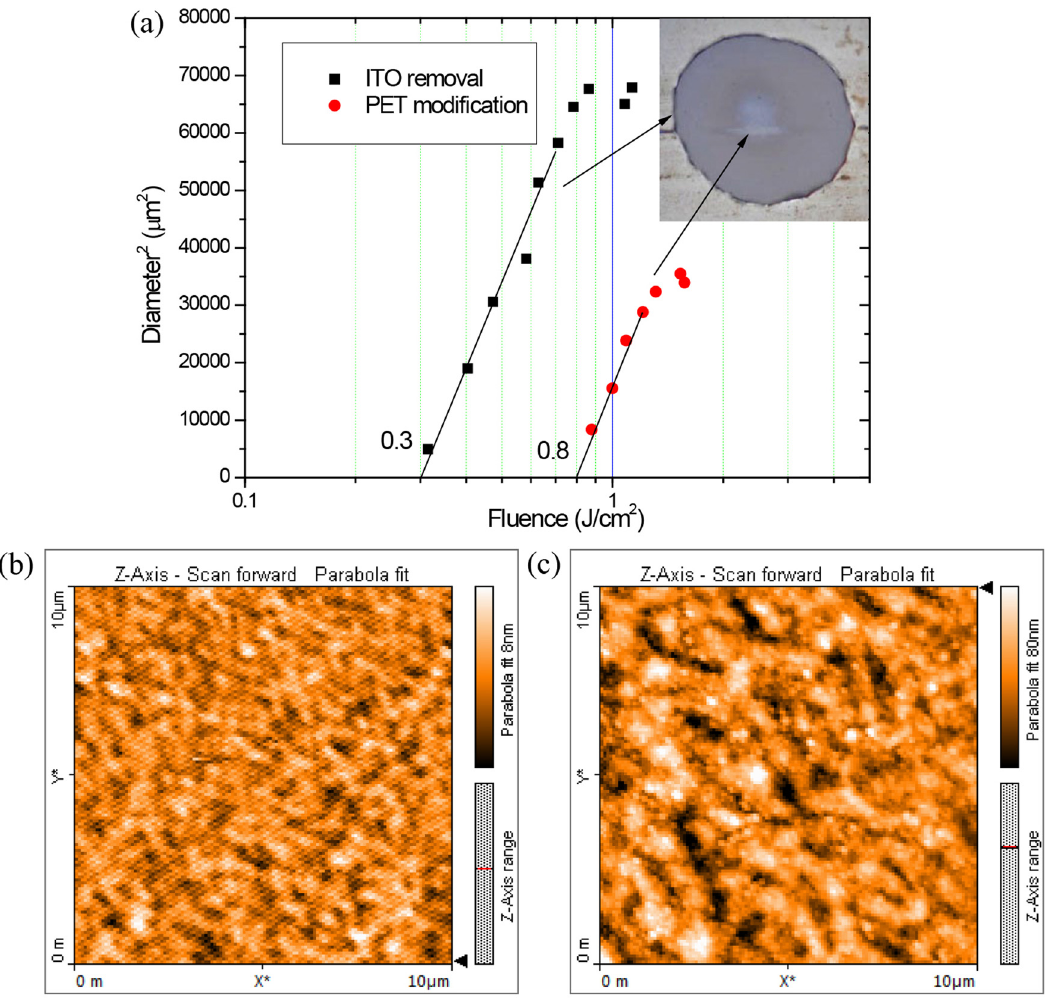
Figure 8: ( a ) Threshold fl uence for fs laser ablation of ITO on PET ( b ) AFM images of the unmodi fi ed PET surface ( left, color scale: 8 nm ) with R = 1.1 nm and the modi fi ed PET surface at 250 μ J ( right, color scale: 80 nm ) where R a